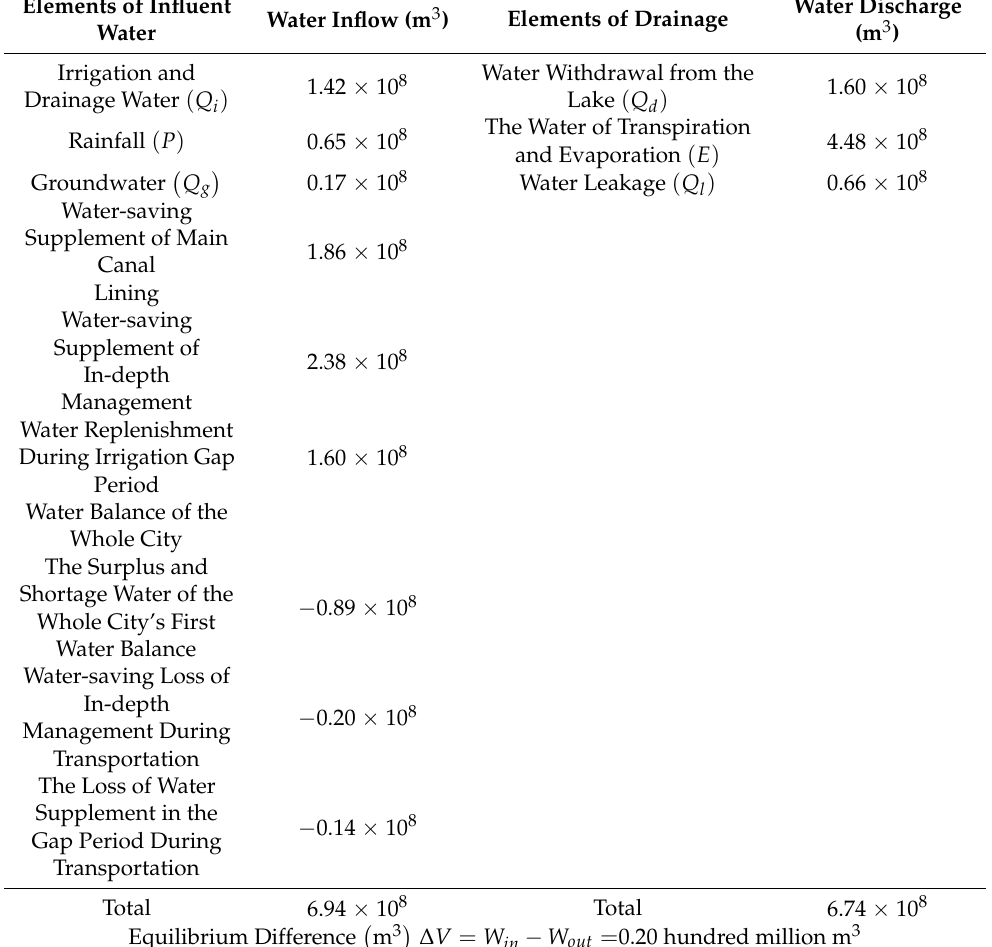
Table 4. The analysis table of second water balance of Wuliangsuhai Lake in 2020. Elements of Influent